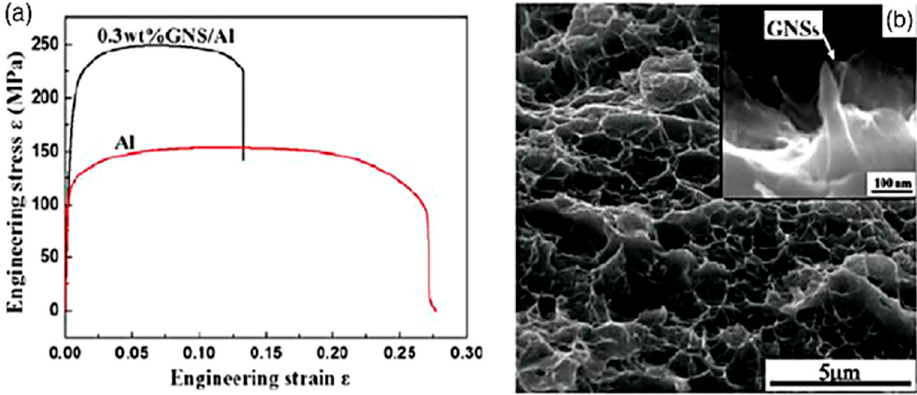
Figure 6. ( a ) Tensile characteristics of Al–0.3 wt.% graphene nanosheet (GNS) nanocomposite and